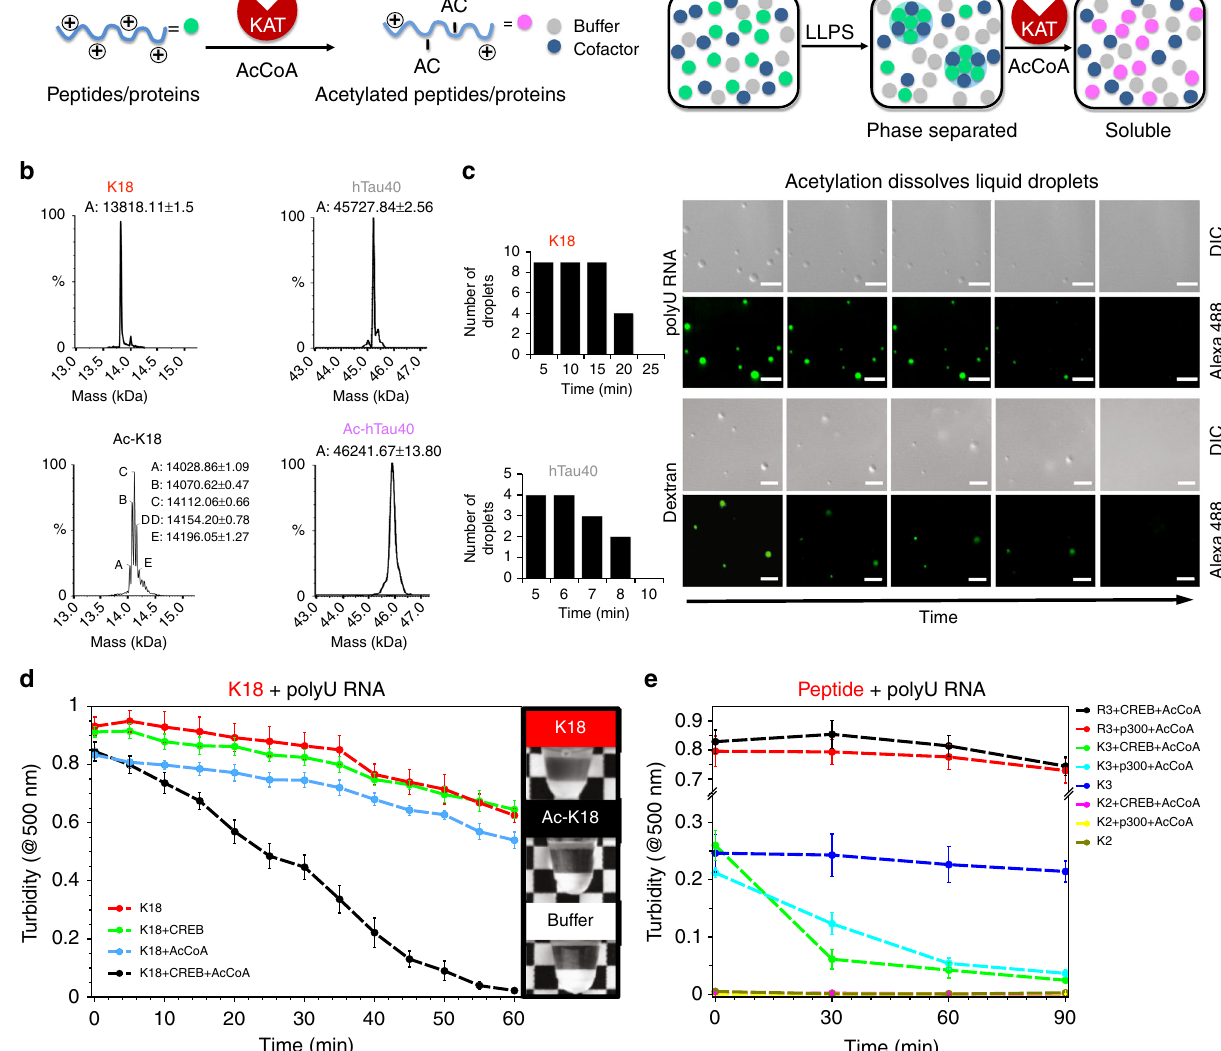
Fig. 6 Acetylation reverses lysine-driven coacervation. a Cartoon representation illustrating acetylation of lysine-rich polypeptides by lysine acetyltransferase (KAT) in the presence of acetyl-Coenzyme A (AcCoA) (left) and its in fl uence on lysine/RNA coacervation (right). b Mass spectra of K18 and hTau40 samples before (top) and after acetylation by CREB (bottom). Identi fi ed masses (in Da) are indicated. c DIC and fl uorescence images show dissolution of K18/RNA (top; 50 µ M K18, 125 µ g ml − 1 polyU RNA in 25 mM HEPES, pH 7.4) and hTau40/dextran (bottom; 50 µ M hTau40, 10% dextran in 25 mM HEPES, pH 7.4) droplets in the presence of the acetyltransferase CREB and AcCoA. Time-dependent changes in droplet numbers were quanti fi ed (left). Experiments were performed three times for each protein sample. d , e Turbidity measurements of K18 (50 µ M; d ), as well as arginine- (R3; 1 mM) and lysine-rich (K2 and K3; 1 mM) peptides ( e ), which underwent LLPS through addition of polyU RNA (125 µ g ml -1 for K18, 0.5 mg ml -1 for the peptides), in the presence of either CREB/p300 or AcCoA, or both the enzyme and AcCoA. In the middle, photographs of the respective K18 samples after 60 min are depicted. Reported values represent an average of three independent samples. Error bars in d and e correspond to ± SD. Source data are provided as